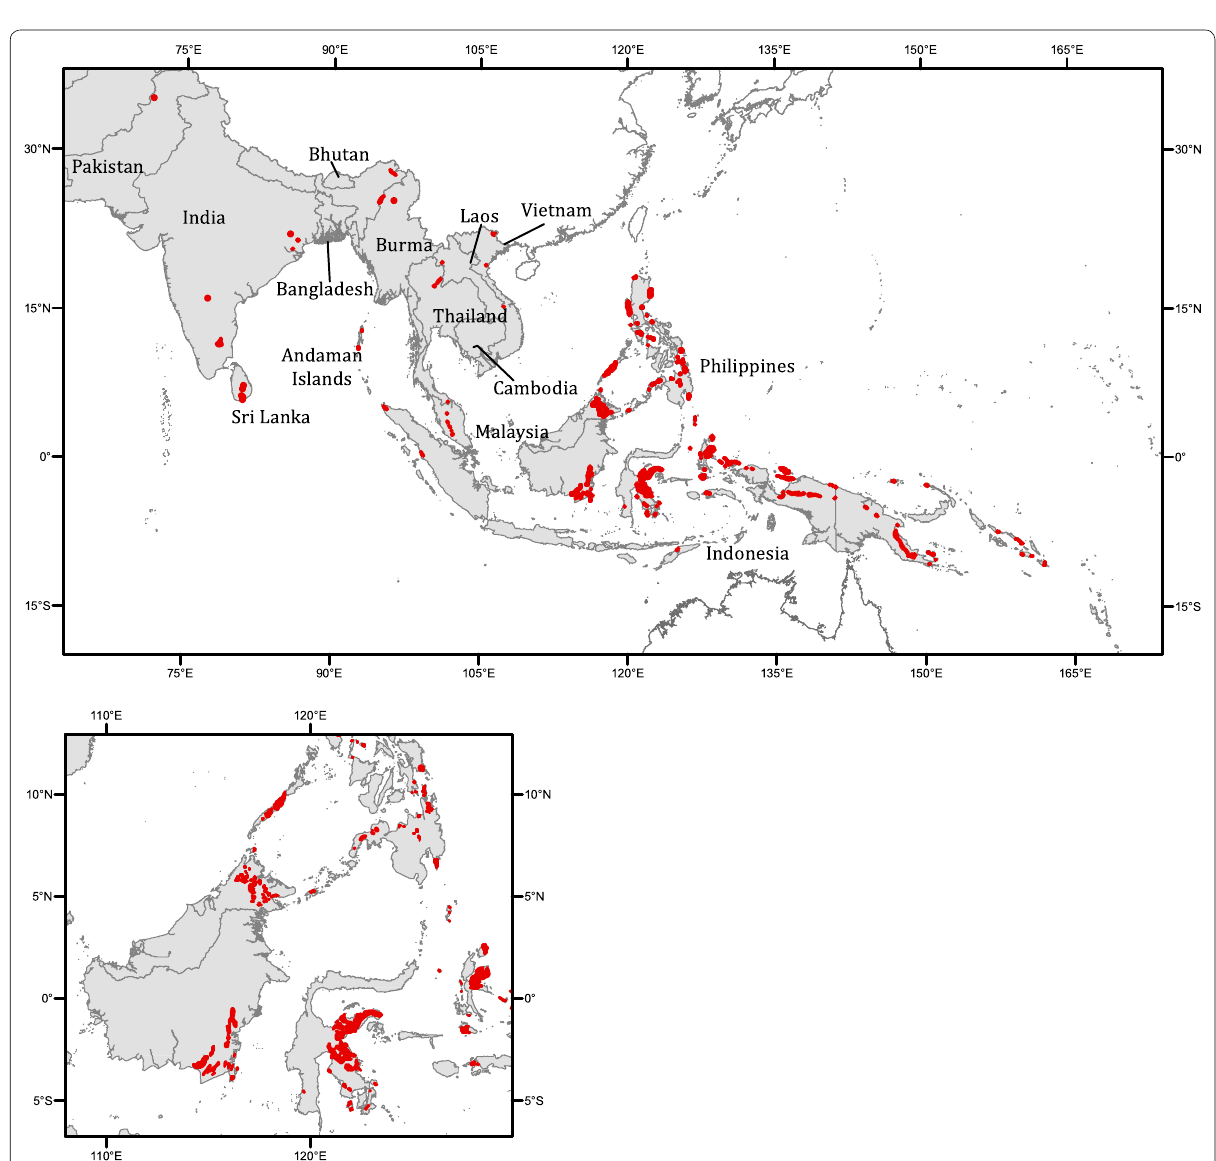
Fig. 1 Map of South and Southeast Asia showing the distribution of ultramafic outcrops in the region. Bottom inset is a more detailed outline of ultramafic outcrops in Borneo, Palawan, Mindanao, Sulawesi, and Halmahera. Not all regions of India have complete geologic surveys, and we were unable to locate precise information about ultramafic outcrops in Burma and Laos. The ultramafic outcrop location in Northern Thailand is approximate. The extent of each outcrop shown is not to scale [Figure compiled with data from Central Energy Resources Team (1999), Datta et al. (2015), Kfayatullah et al. (2001), Shi et al. (2012), Baker et al. (1992), Van der Ent et al. (2013a, 2015a), Tan and Khoo (1993), MacDonald and Barr (1984), Geological Survey of India, Geological and Mineral Maps of States and Regions (http://www.portal.gsi.gov.in/portal/page?_pageid dad portal&_schema PORTAL), and OneGeology Portal = =